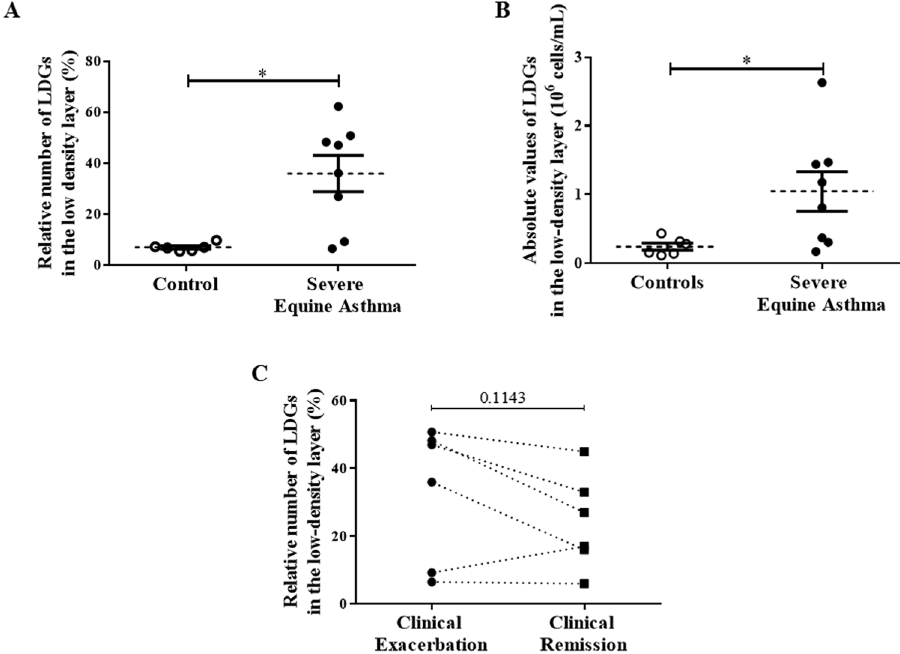
Figure 1. Levels of low-density neutrophils (LDNs). ( A,B ) Percentages and numbers of LDNs in peripheral blood mononuclear cells (PBMCs) of controls and horses with severe equine asthma during disease exacerbation. Each symbol denotes a single animal, and the mean ± SEM for each study population is shown. * p < 0.05 compared with control. ( C ) Percentages of LDNs in PBMCs of horses with severe equine asthma, comparing clinical exacerbation with clinical remission (p = 0.1143). Each symbol denotes a single